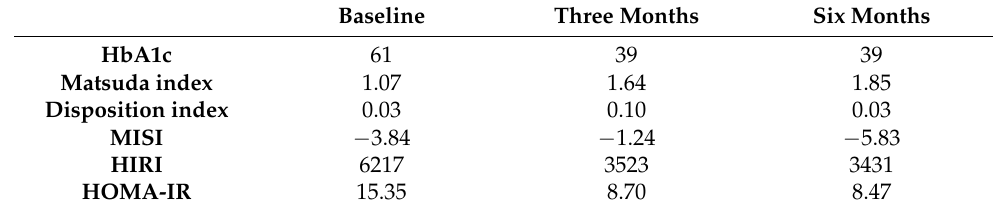
Table 6. HbA1c and T2D indices derived from OGTT for participant B at baseline and after three months and six months of intervention.